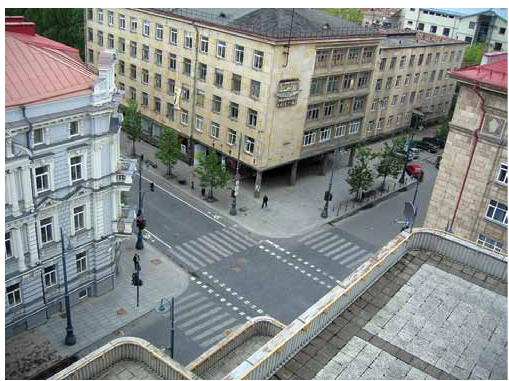
terasos. a. novicko nuotr. Fig. 10. View from the terrace of the Palace of the lithuanian Cooperative union. a. novickas photo